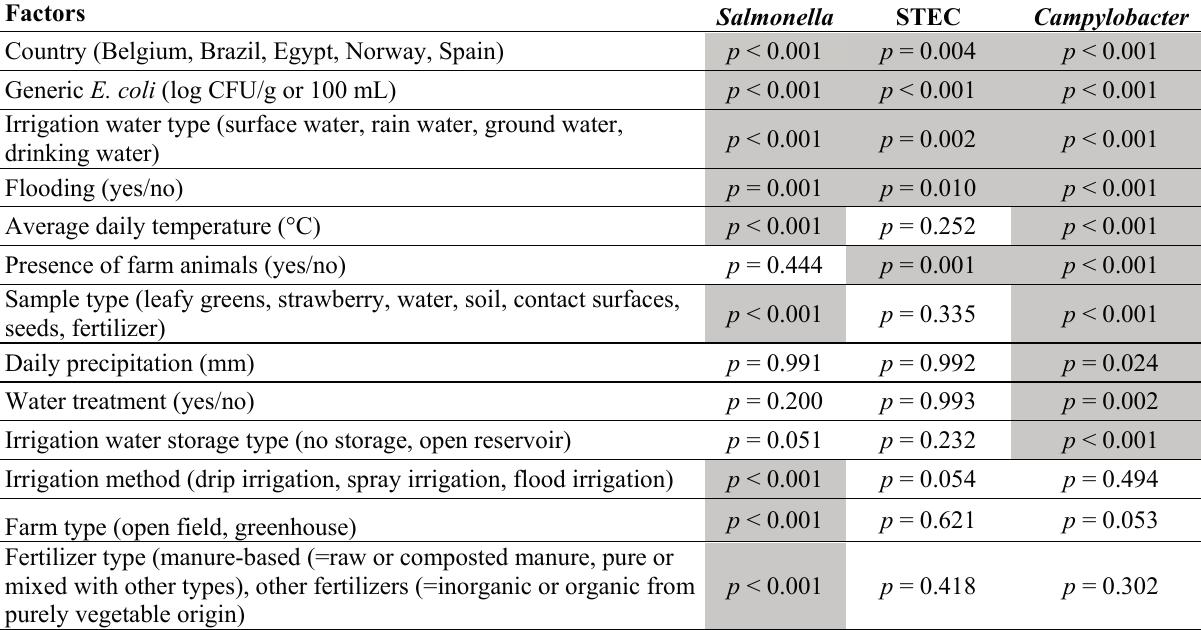
Table 4. List of factors which were univariably investigated in logistic regression for significance (see p -value, significance at the 5% level is indicated by grey